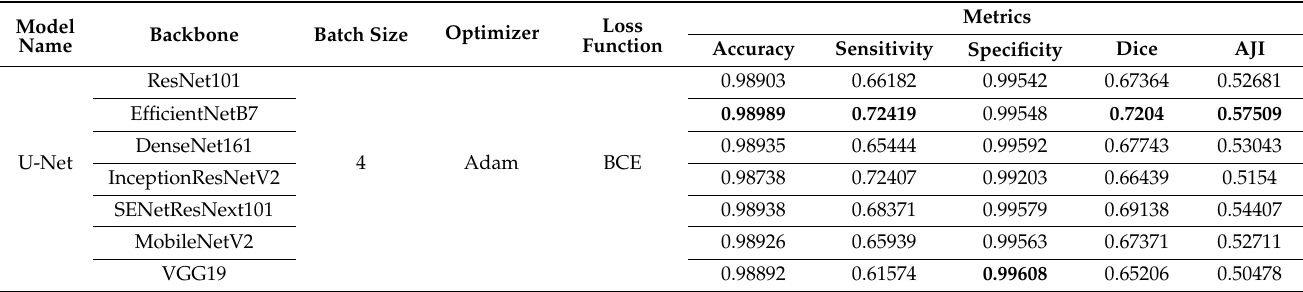
Table A1. Comparative results of U-Net with the different backbones and the batch size of 4 (bold represent the best performance).